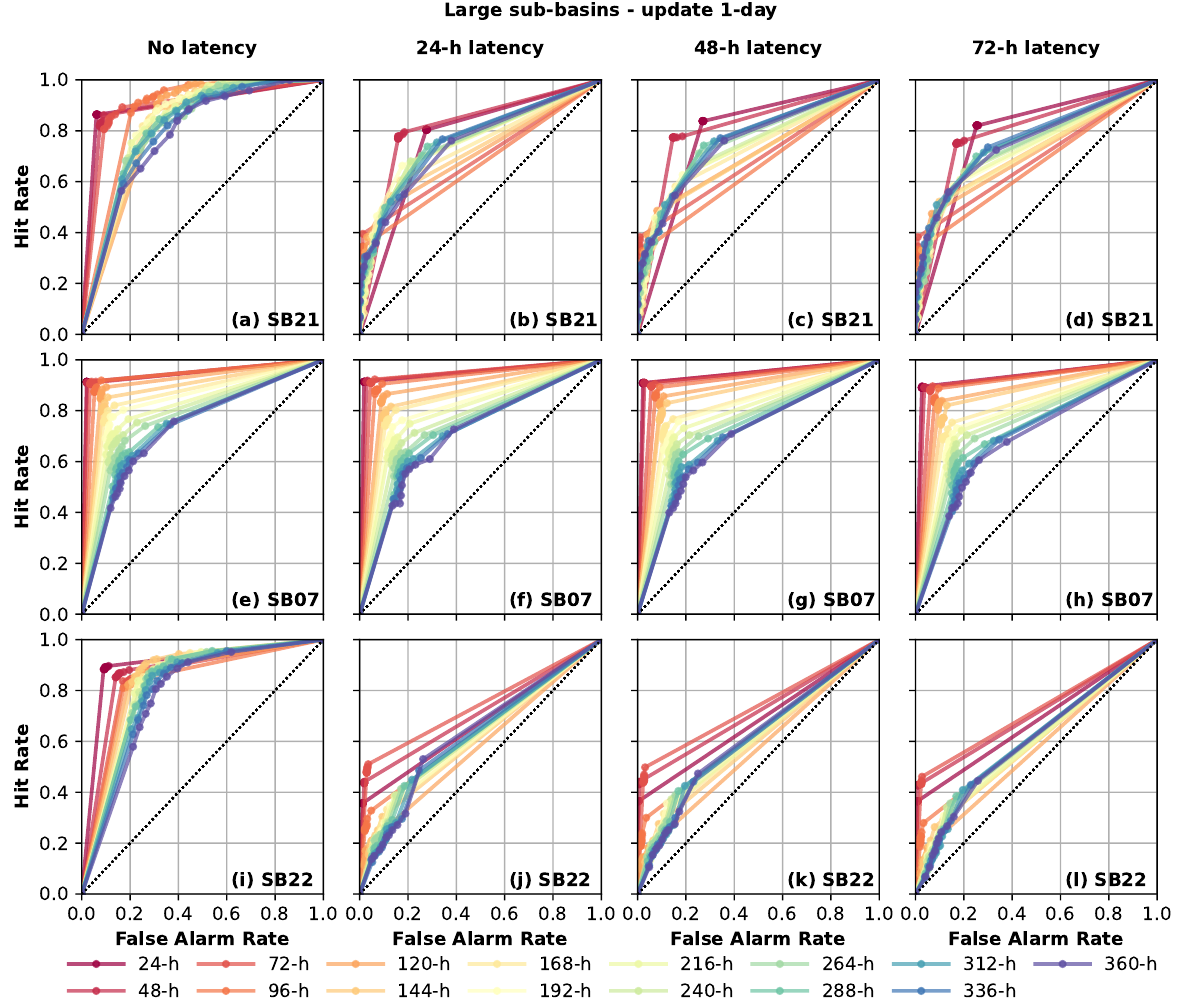
Figure 10. ROC diagrams of the probabilistic streamflow forecast for large sub-basins. MHD-INPE 1 d update for: no latency (left column), 24 h latency (center-left column), 48 h latency (center-right column), and 72 h latency (right column), for streamflow with a probability level of